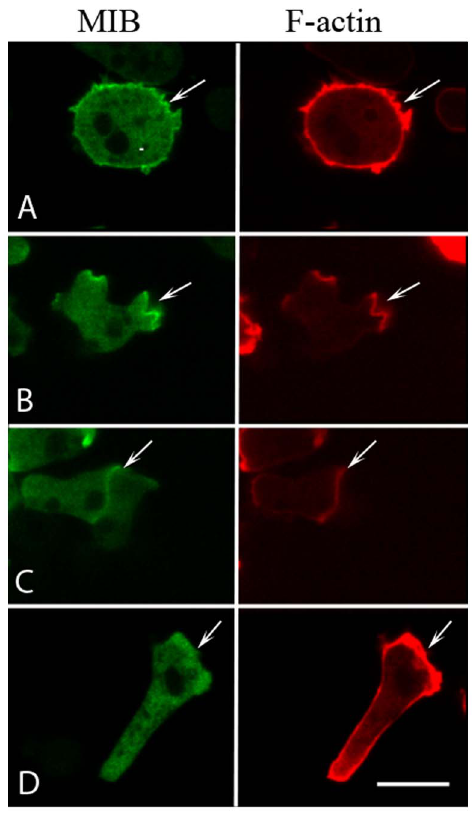
Figure 1. Expression of lifeact does not affect localization of MIB in myoB 2 -cells. myoB 2 -cells were co-transfected with mRFP- lifeact and GFP-MIB, and the localization of F-actin and MIB were monitored in live cells. MIB co-localized with F-actin: (A) at the plasma membrane of freshly plated cells; (B) in protrusions of cells starved for 1–2 h; (C) at cell-cell contacts of cells starved for 1–2 h; and (D) at the front of elongated cells moving directionally. The arrows point to the sites enriched in MIB. Bar is 10 m